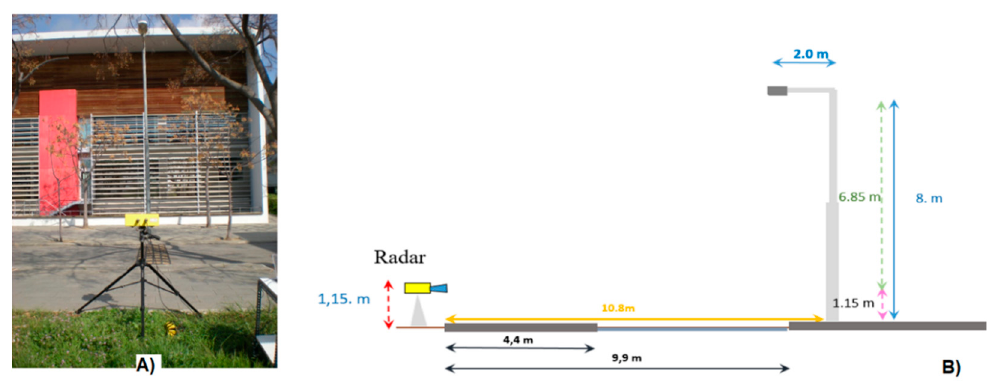
Figure 9. (A) Picture of the measurement setup. (B) Scheme of measurement geometry used to Figure 9. ( A ) Picture of the measurement setup. ( B ) Scheme of measurement geometry used to evaluate evaluate the response of a light pole with different polarization configurations. the response of a light pole with different polarization configurations.